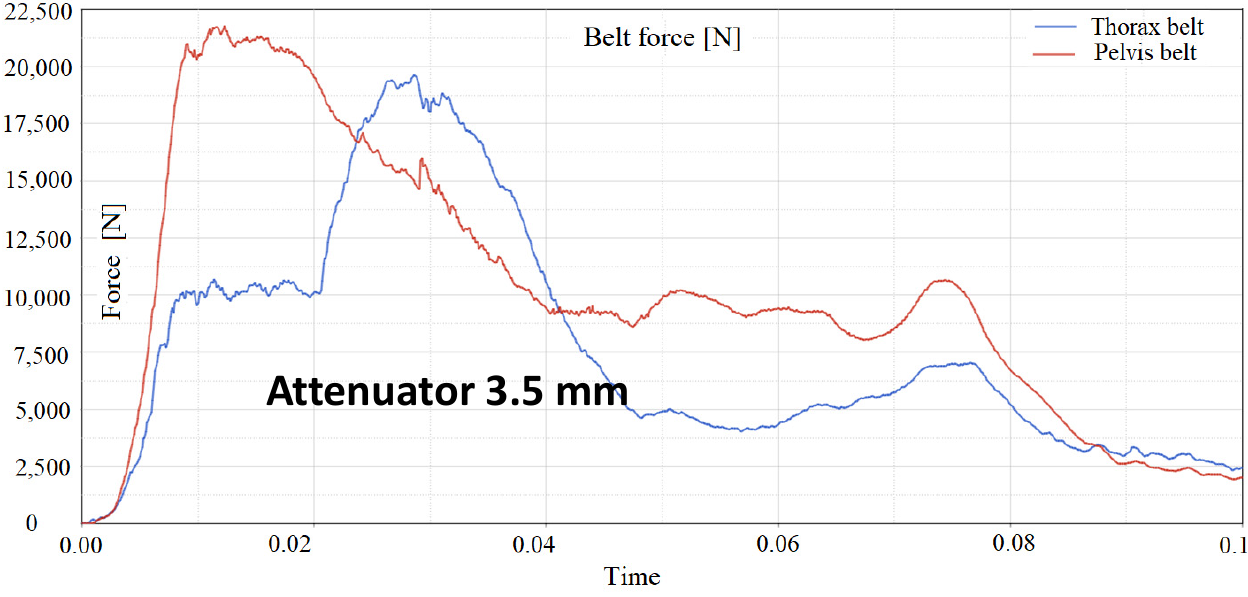
Figure 8. The forces in the thorax and pelvis belts. The shock absorber had a thickness of 2 mm.